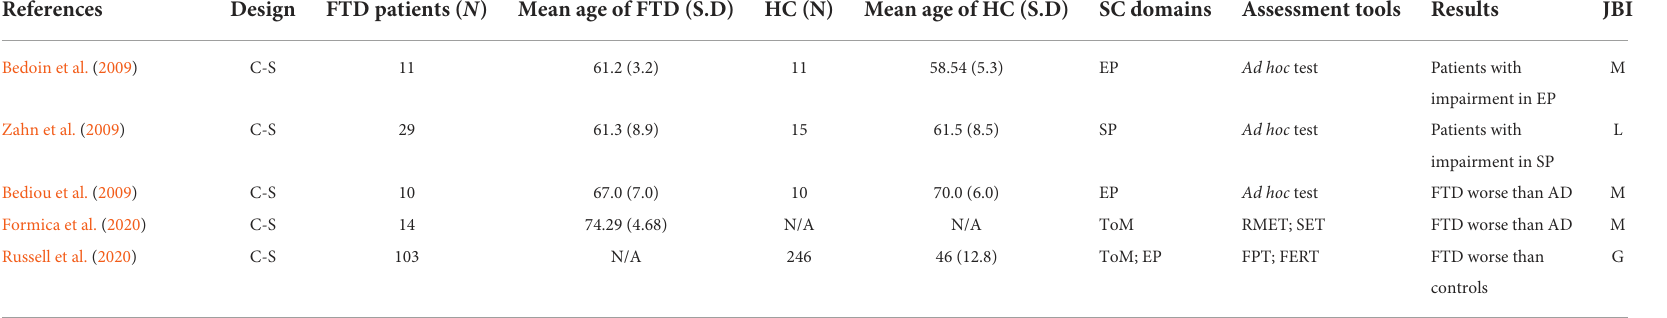
TABLE 7 Summary of studies on social cognition in unspecific frontotemporal